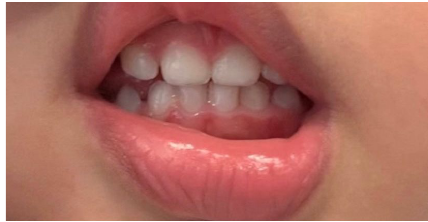
Figure 7. Anterior overlap and reestablishment of the anteroposterior relationship after performing the exercises.